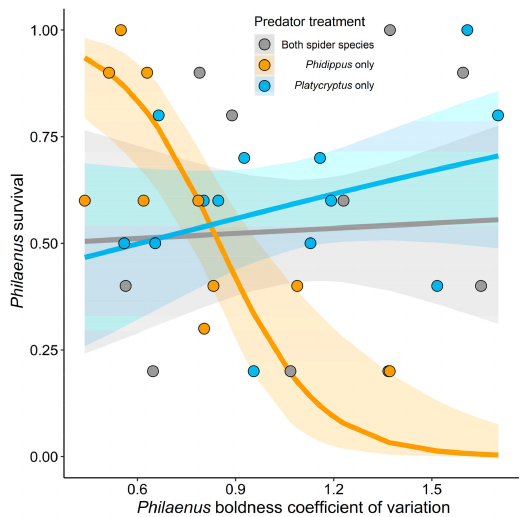
Figure 2. Direct e ff ect of Philaenus prey boldness variance on Philaenus proportional survival in the Phidippus spider predator treatment. Field mesocosms were stocked with 10 Philaenus individuals, and population-level boldness variance was calculated as the coe ffi cient of variation in boldness across these 10 individuals. Shaded areas around marginal e ff ect regression lines represent 84% confidence intervals generated using the “ggpredict” function in the R package “gge ff ects” [43]. Eighty-four percent confidence intervals approximate significant di ff erences at a 95% confidence level [44].